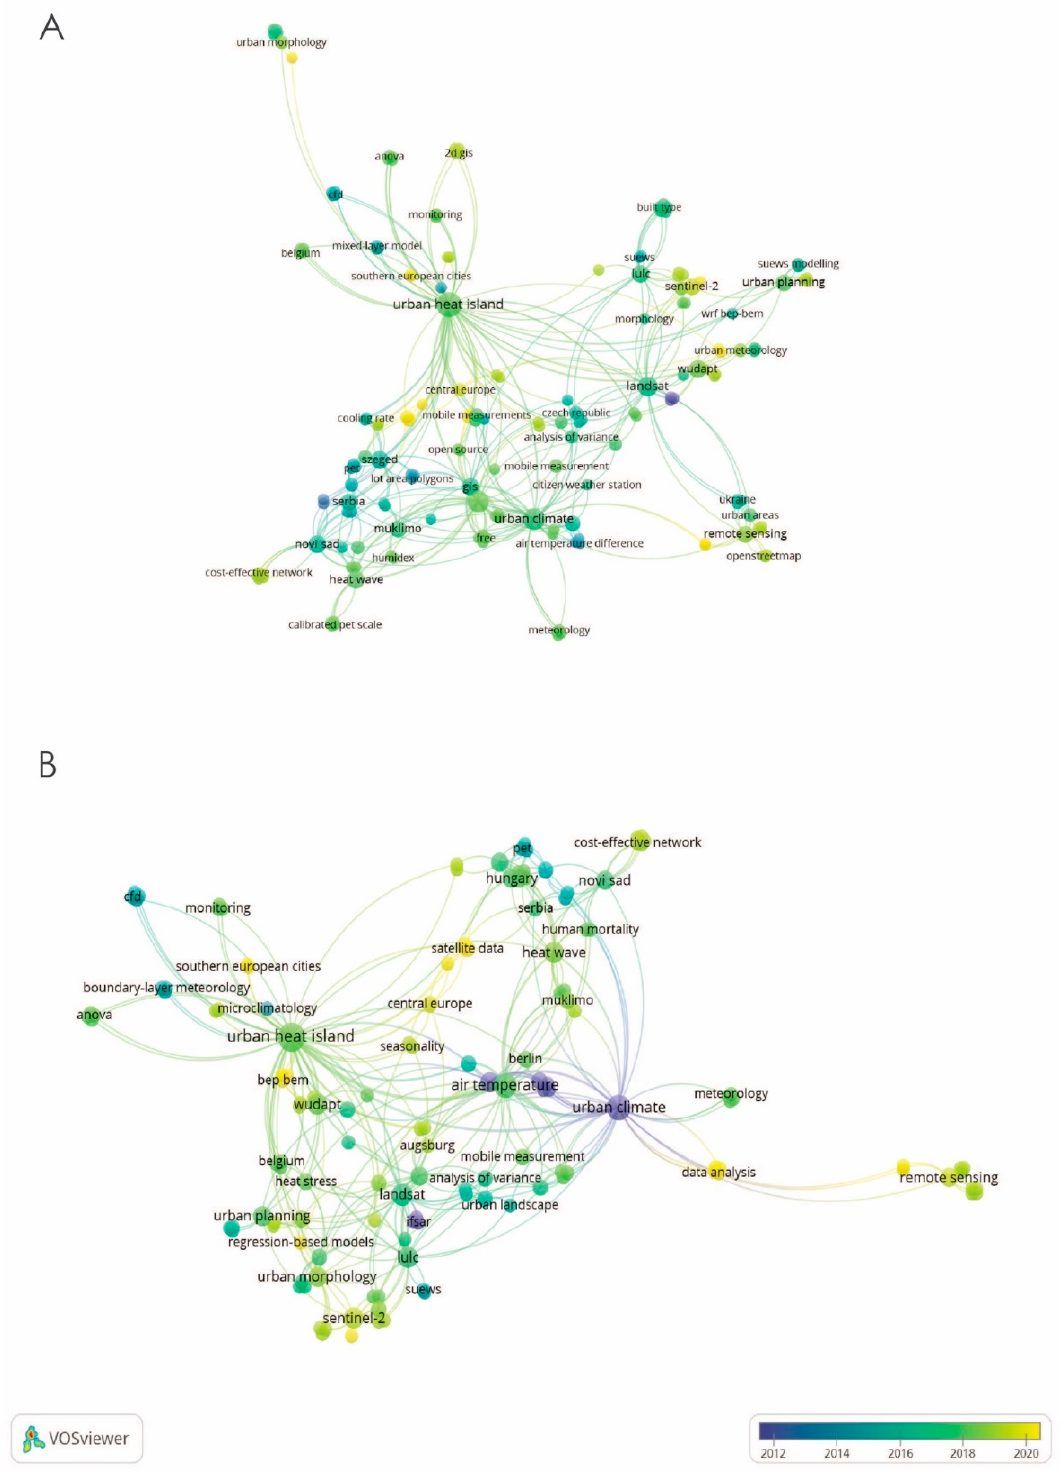
Figure 4. Analysis of authors’ keyword co-occurrence in selected articles from Scopus ( A ) and WoS ( B ).